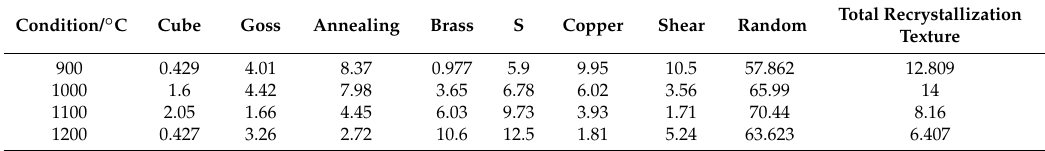
Table 2. Texture compoents (%) for Inconel625 alloy under different